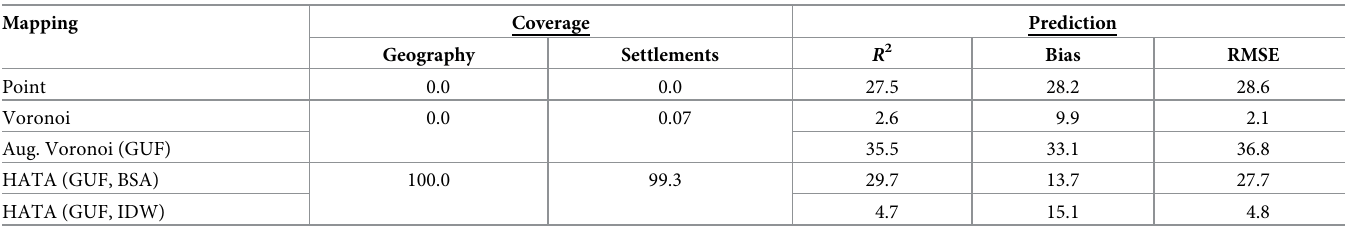
Table 2. Best performing approach by round across rounds (in%).